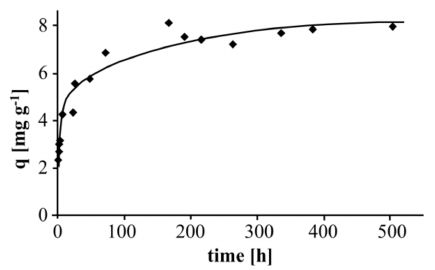
Figure 4. Effect of contact time on the adsorption of